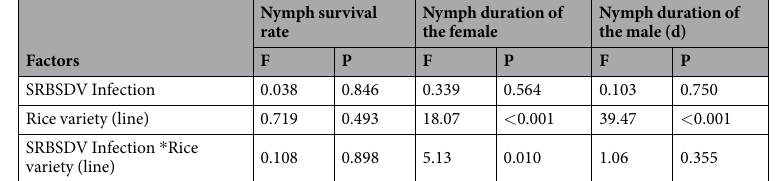
Table 4. ANOVA of effects of transgenic rice plants infected with SRBSDV on nymph survival rate and duration of BPH.